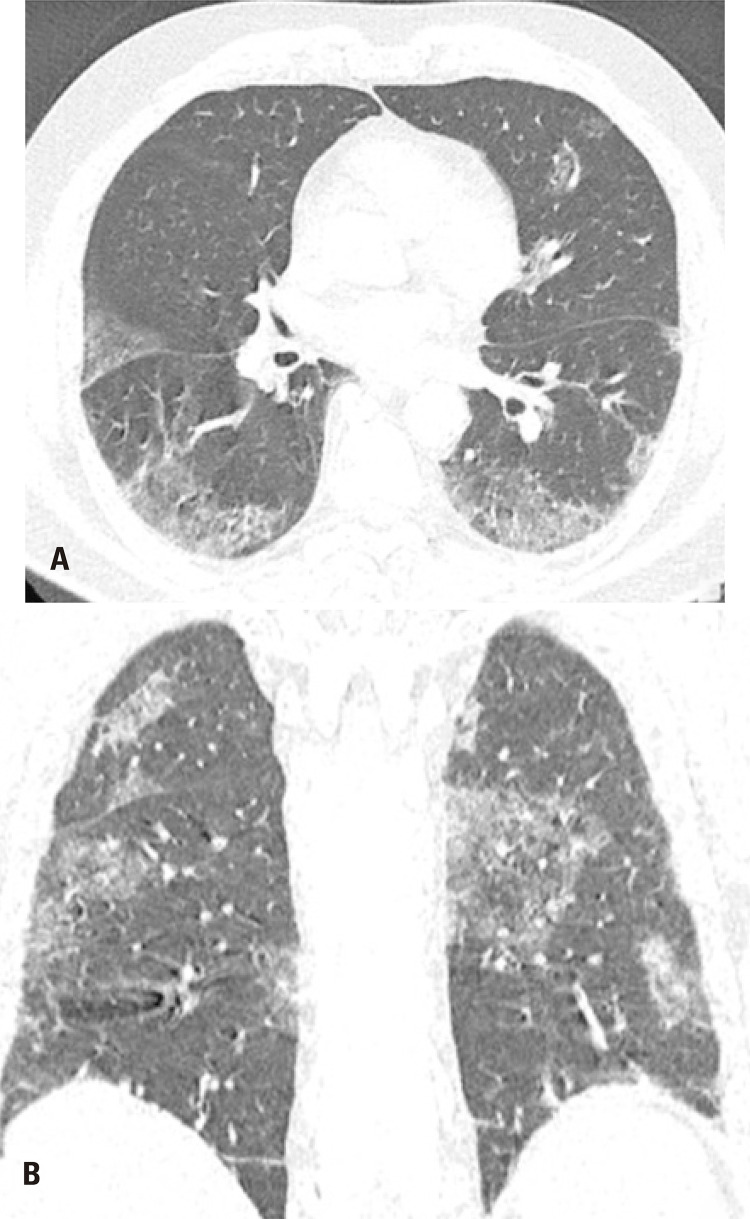
Paciente do sexo masculino, 68 anos, com queixa de tosse seca, febre, mialgia e dispneia. Tomografia computadorizada (A) Axial (B) Reformatação coronal: múltiplas opacidades pulmonares em vidro fosco, por vezes associadas a espessamento de septos interlobulares e reticulado de permeio, em distribuição multifocal, bilateral, predominantemente periférica e posterior